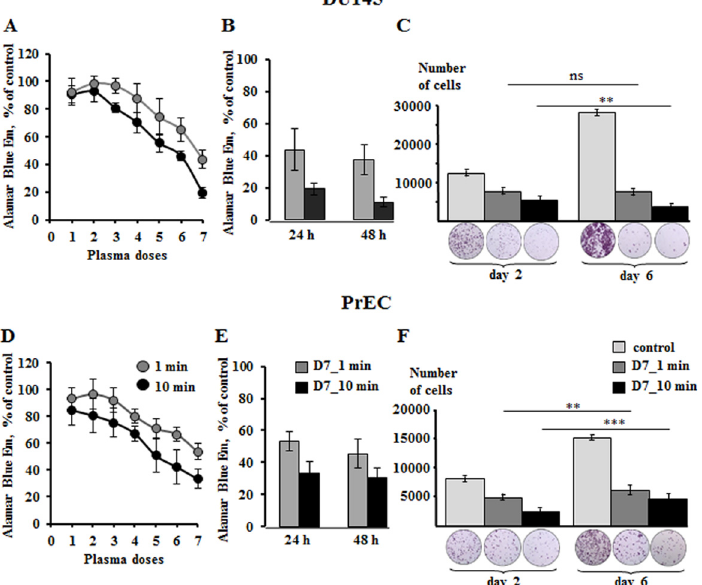
Fig 1. Cytotoxicity of non-thermal plasma on prostate DU145 cancer and PrEC normal cells. The cells were exposed to PBS treated with different plasma doses for 1 and 10 minutes, followed by dilution with growth medium and incubation for 24 and 48 hours. To simplify the understanding of non-thermal plasma doses, the plasma obtained at different physical parameters ( Table 1 ) was named numerically as Dose 1, 2, etc. As seen from the graphs A and D the highest cytotoxic dose was Dose 7 (D7). ( B,E ) The quantitative graphs of the plasma induced cytotoxicity for both prostate cancer and normal cells. ( C,F ) The data and images obtained from the colony formation assay. The benign PrECs treated with plasma D7 for 1 and 10 minutes followed by PBS dilution with growth medium were cultivated for 6 days. They retain their proliferative activity while the cancer cells treated in the same way lose the ability to form colonies. Data presented as mean ± SEM (n = 3).